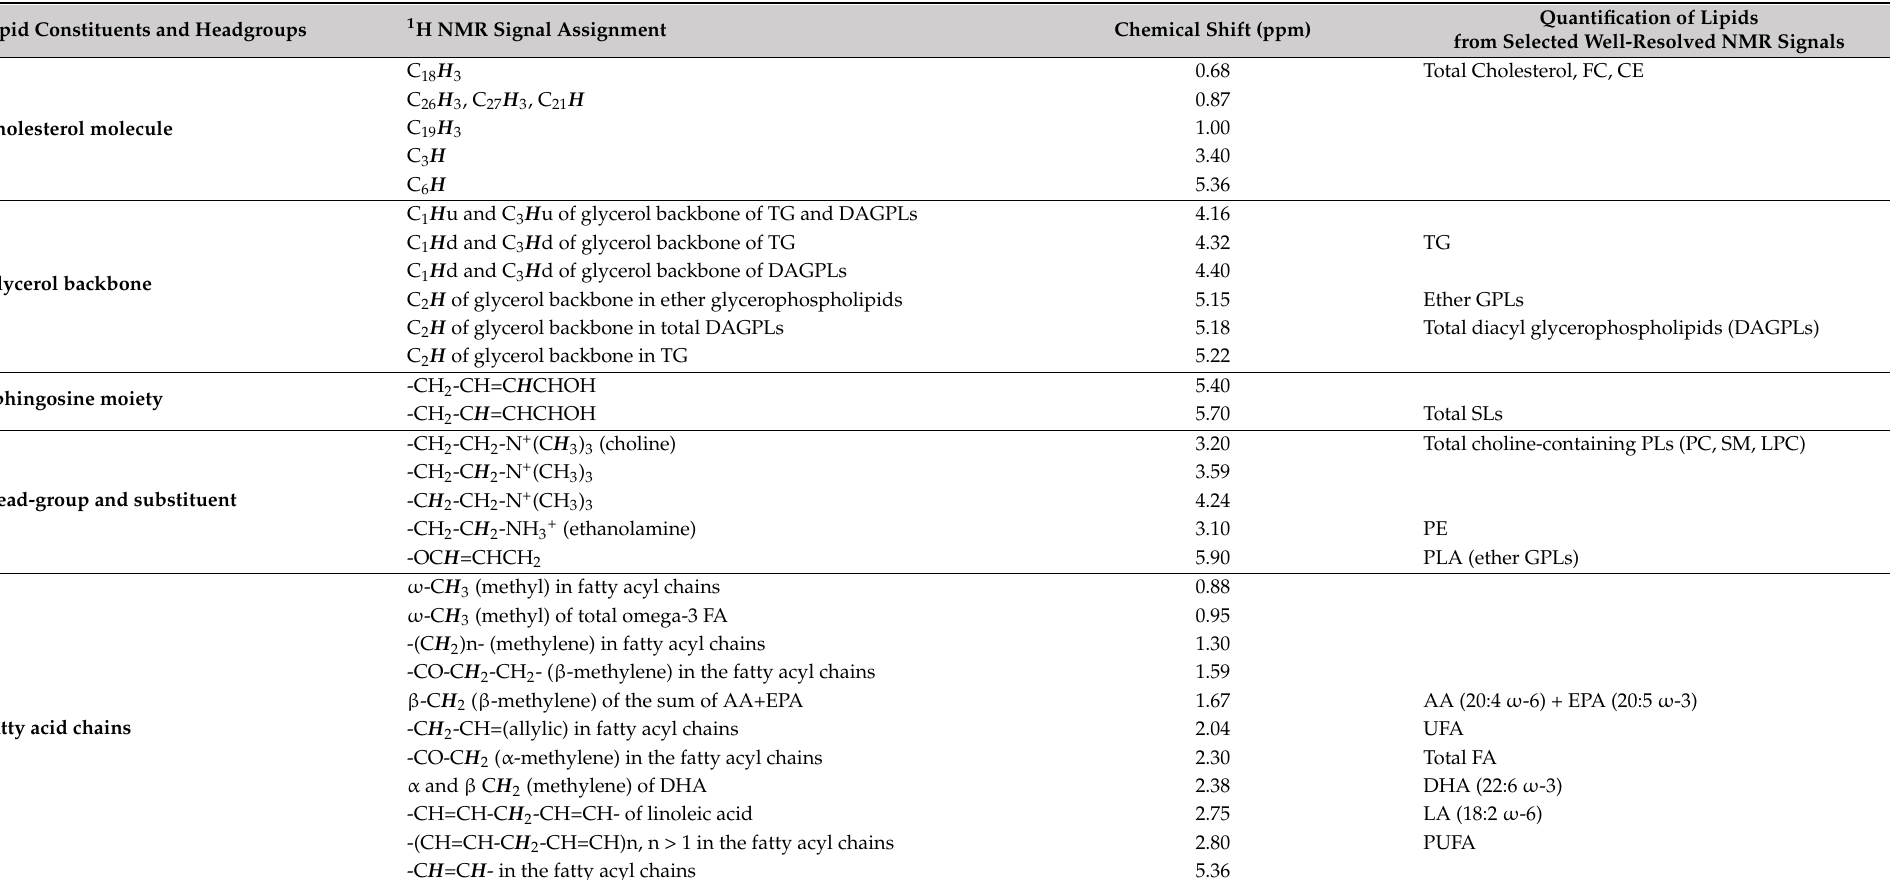
Table 1. Protons and chemical shift (in ppm) for the lipid constituents and headgroups identified in HDL lipid extract by NMR and selected signals for lipid